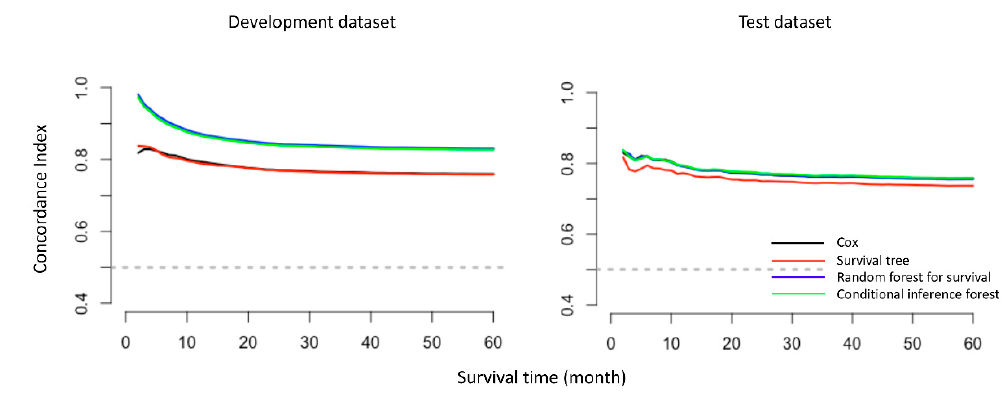
Figure 2. Overtime C-index for predicting disease-specific survival of oral and pharyngeal cancers with various models (Cox regression, survival tree (ST), random forest for survival (RF) and conditional inference forest (CF)) based on the complete case analysis.